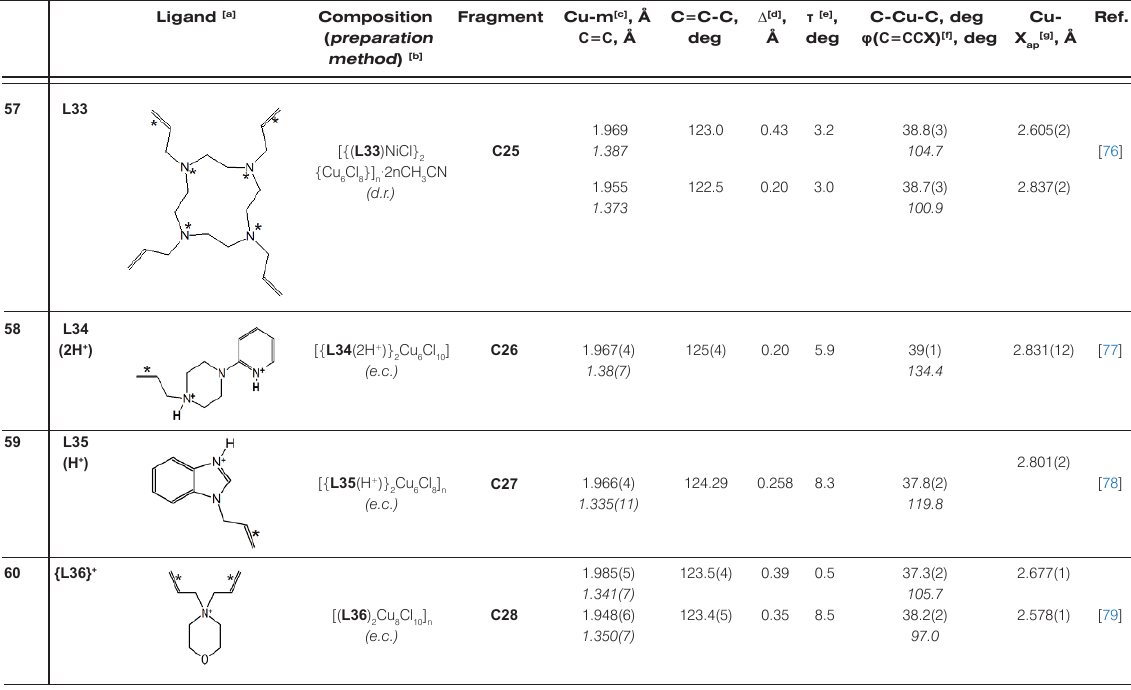
display of the steric hindrance due to an appearance of a peculiar zigzag coordination chain in 2 should not be excluded (Fig. 2 ). The architecture of another molecular complex 3 is caused by the chelate role of S-allyl-benzimidazole-2-thiol ( L3 ), where both the olefinic C=C bond of the allyl group and the N atom of the imidazole ring are combined by a Cu(І) atom into the six-membered organometallic cycles [ 42 ]. Moreover, the lower nucleophilic activity of the heterocyclic N atom and a large lability of the S-allyl group in 3 , favor a formation of a pseudodimeric centrosymmetric fragment [( L3 ) Cu Cl ] ( C2а ), in which current Cu ... Cl contacts 2 2 2 at adistance of 3.03Å between different π-coordinated CuCl units, fit in a hypothetical scope of the Cu(I)- Cl interaction (Fig. 1 a). The reaction of L3 with ap CuBr leads to a formation of an acentric [( L3 ) Cu Br ] 2 2 2 fragment with Cu-Br and distances of 2.88 and 2.99 Å. ap A decrease of the Cu-X distance in replacing a chlorine ap atom by a bromine atom can be explained by a lesser polarizing ability of the Br atom accompanied by a Cu(I) deviation from the base plane of a trigonal pyramid up to Δ = 0.32 Å (Table 1